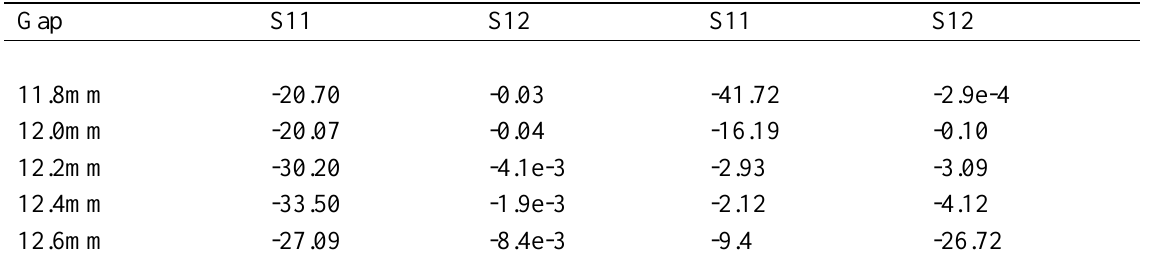
Table 2. Changing the gap width